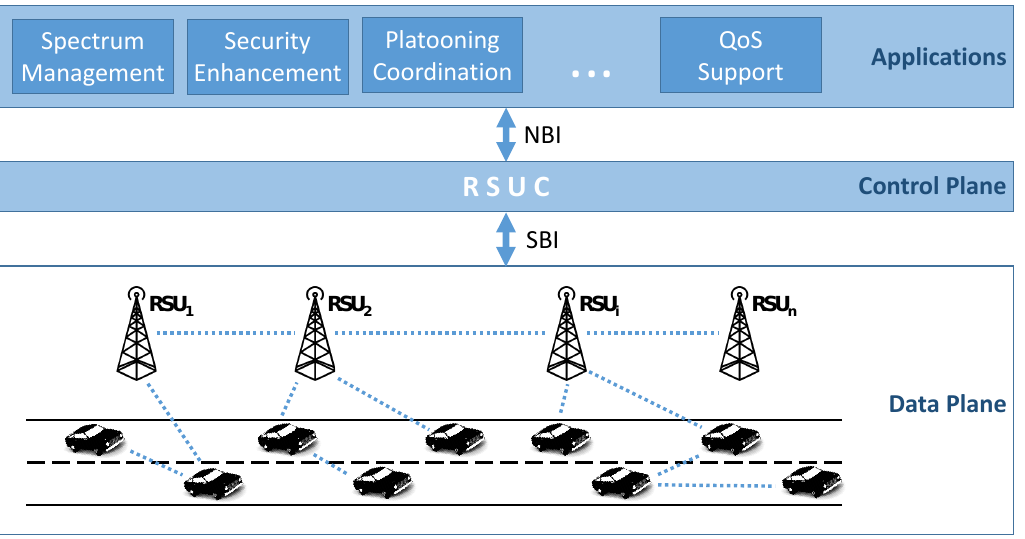
Figure 1. Reference SDN-enabled architecture. The RSU Controller (RSUC) converts the instructions received by the applications into rules that are executed by RSUs and